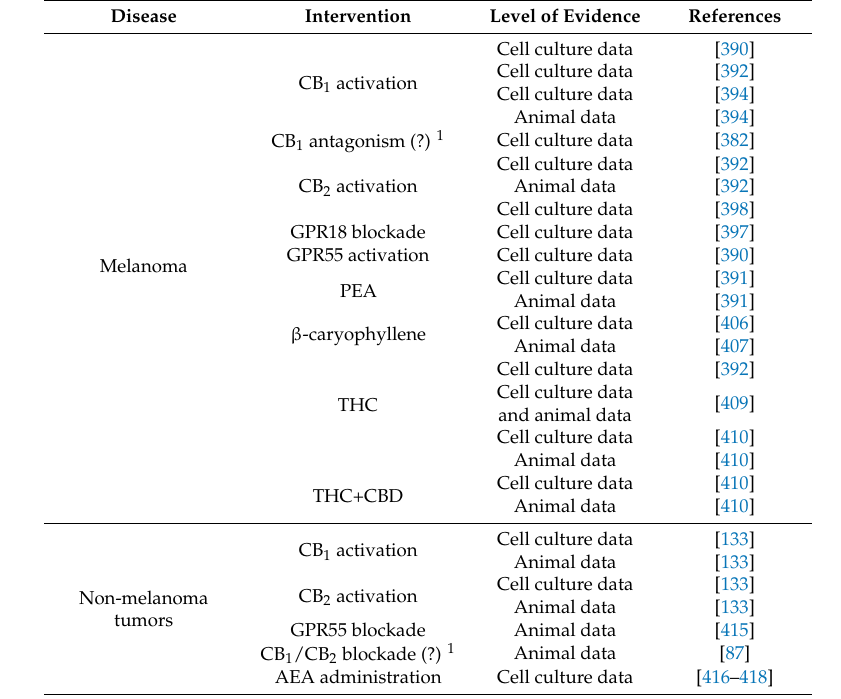
Table 8. Overview of the putative anti-tumor potential of the cutaneous cannabinoid